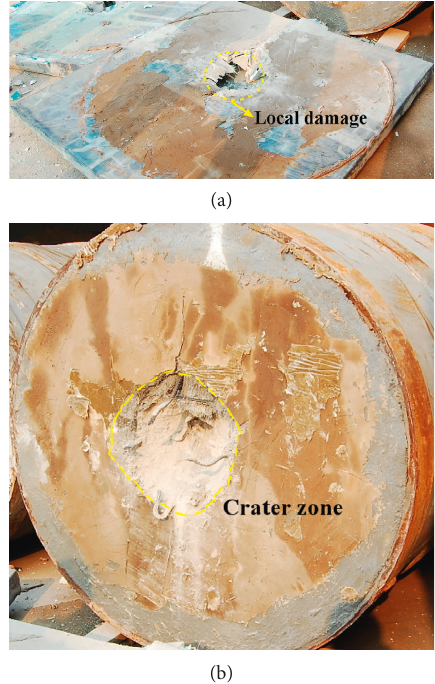
Figure 15: Damage results of FC-RPC target 3: (a) damage of the FC target; (b) damage of the RPC